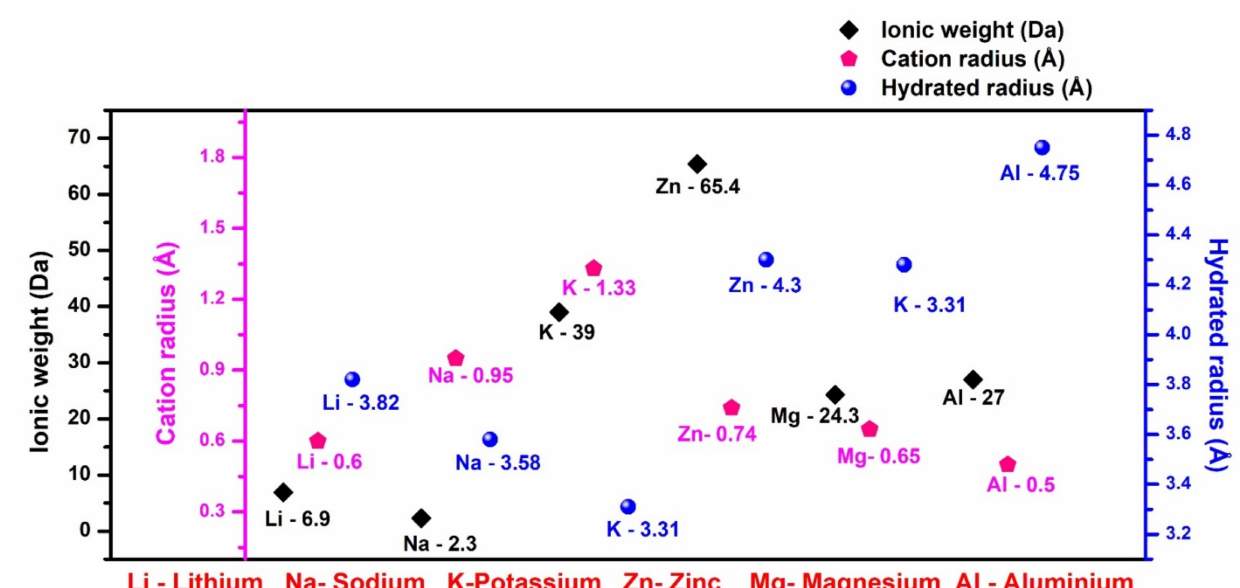
Figure 3. Comparison of ionic radius and weight among Li, Na, and K alkali